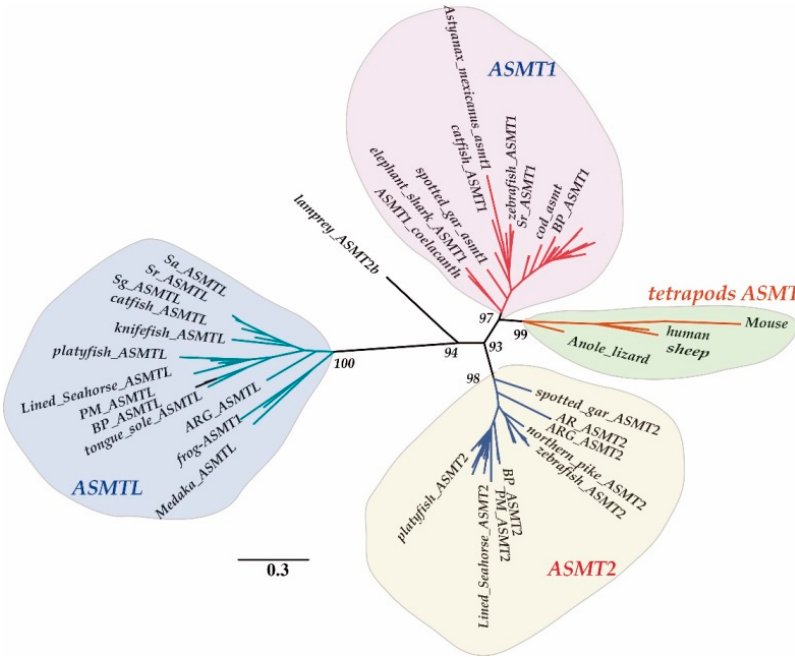
Figure 1. Clustering of ASMT genes. The phylogenetic analysis was performed by RAxML 8.0.17. Numbers on branches are bootstrap values. Scale bar indicates the rate of amino acid substitution per residue. Although the Mega tree is not shown here, it possesses the same tree topology. Different ASMT subfamilies are displayed with various colors: Pink, teleost ASMT1 ; Green, tetrapod ASMT ; Yellow, teleost ASMT2 ; and Blue, teleost ASMTL. Abbreviations of fish species: PM, Periophthalmus magnuspinnatus ; BP, Boleophthalmus pectinirosris ; AR, Golden arowana; ARG, Green arowana; Sa, Sinocyclocheilus anshuiensis; Sg, S. graham ; Sr, S.